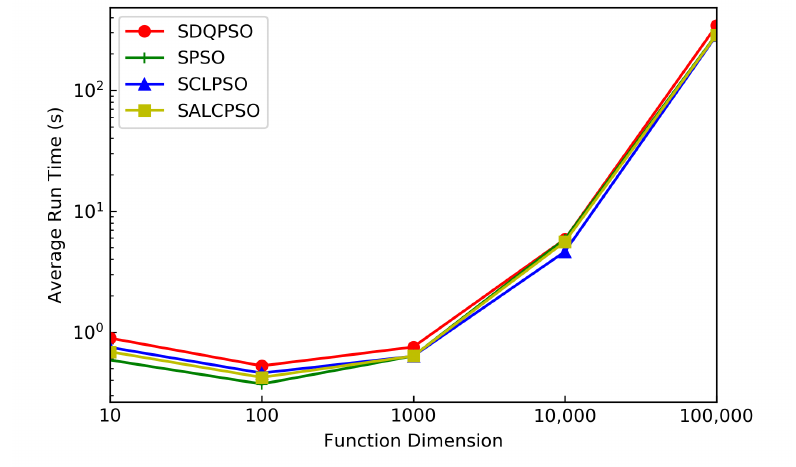
Figure 7. The running time under different dimensions.